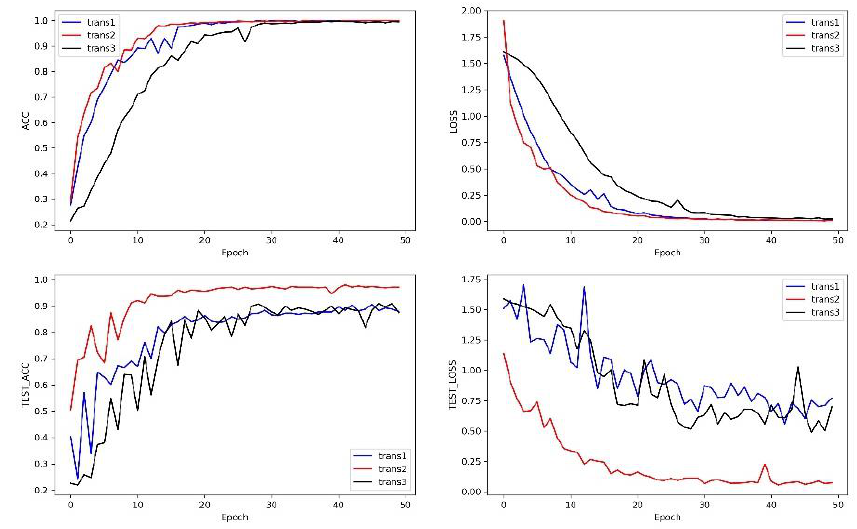
Figure 21. Comparison of three transfer methods under 0.875 data size.